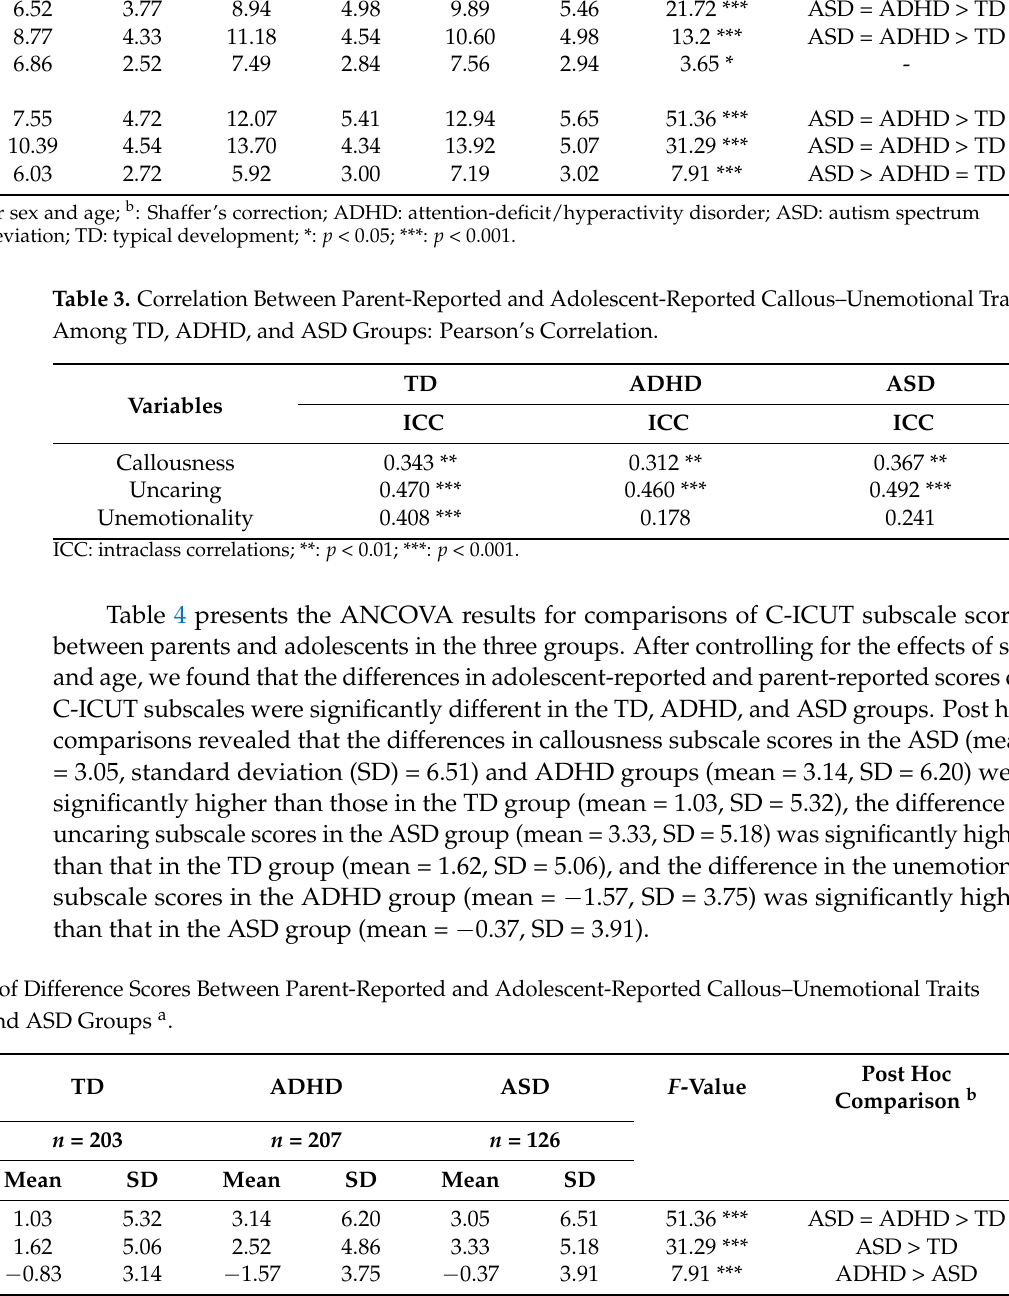
Table 2. Comparisons of Parent-Reported and Adolescent-Reported Callous–Unemotional Traits Among TD, ADHD, and ASD Groups a . TD ADHD ASD F -Value Mean SD